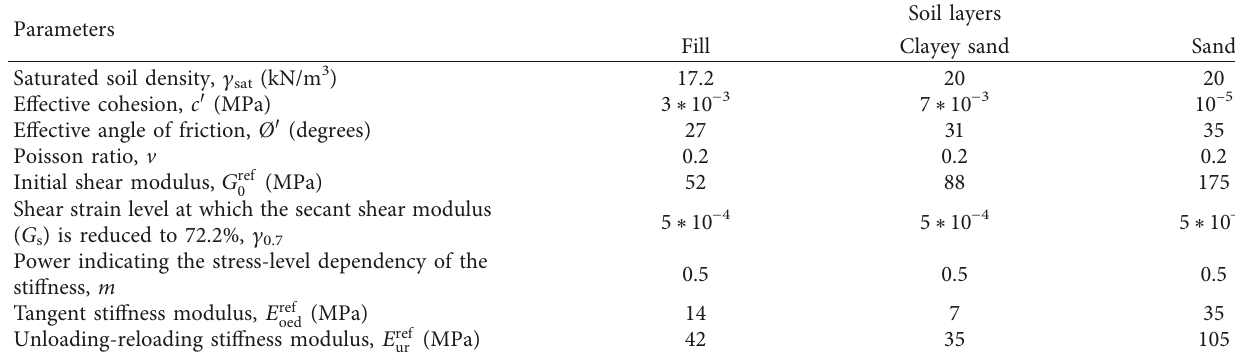
Table 2: Overview of the soil parameters of the Heinenoord